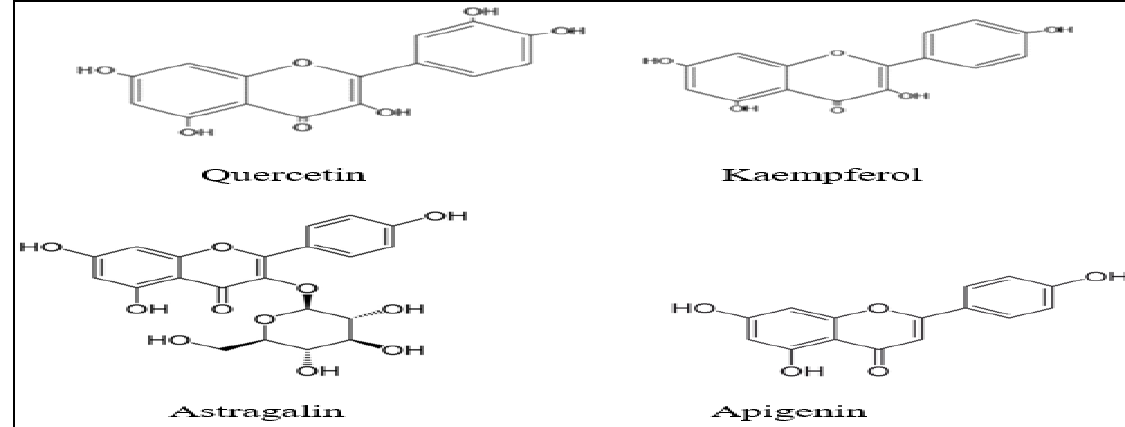
Figure 2. Chemical structures of some flavonoids (35-37) .